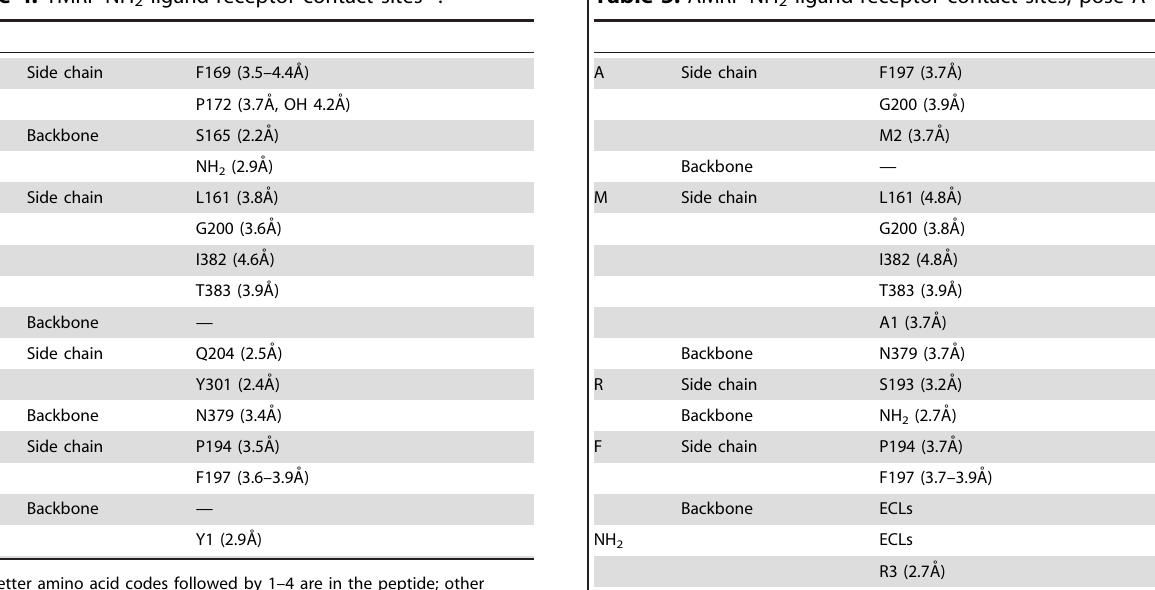
Table 4. YMRF-NH 2 ligand-receptor contact sites a .